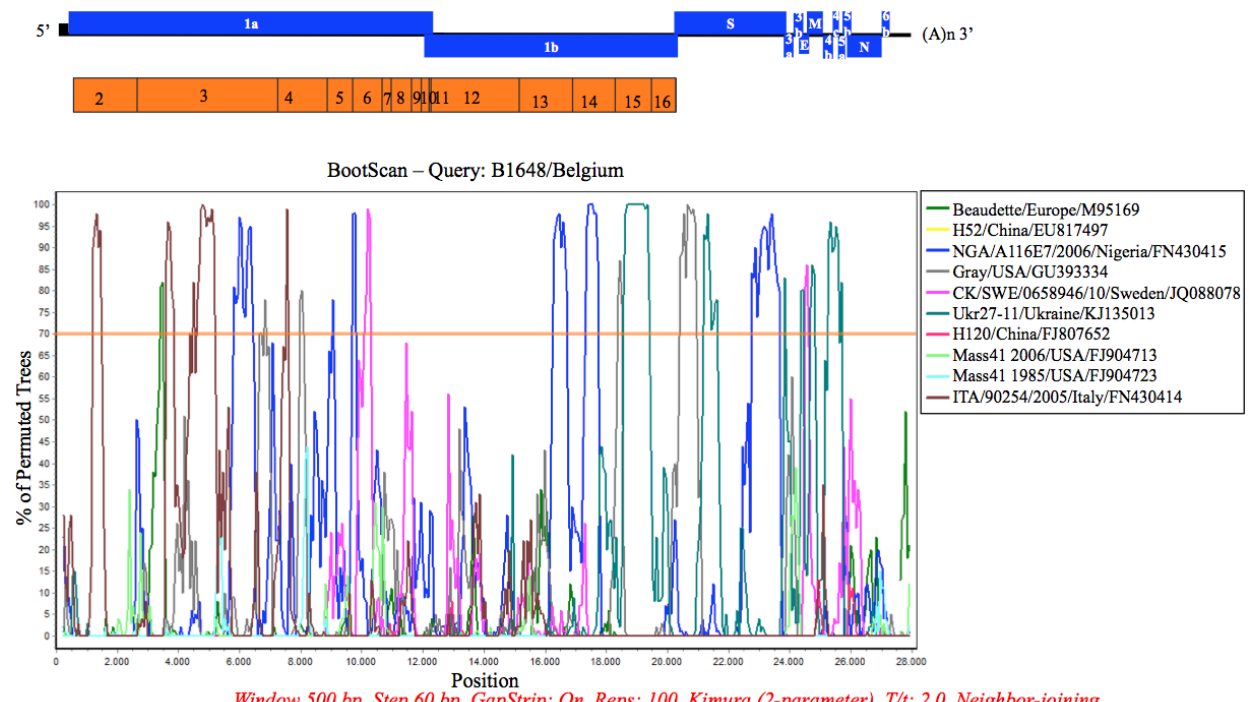
Figure 5. Simplot analysis (Simplot 3.5.1) of B1648 strain. The full genome sequence of B1648 strain was tested against 10 relevant IBV strains. The 70% bootstrap level is considered.